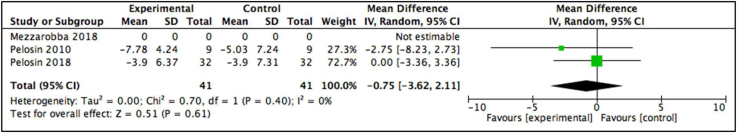
Pooled analysis for the TUG in patients with Parkinson disease.